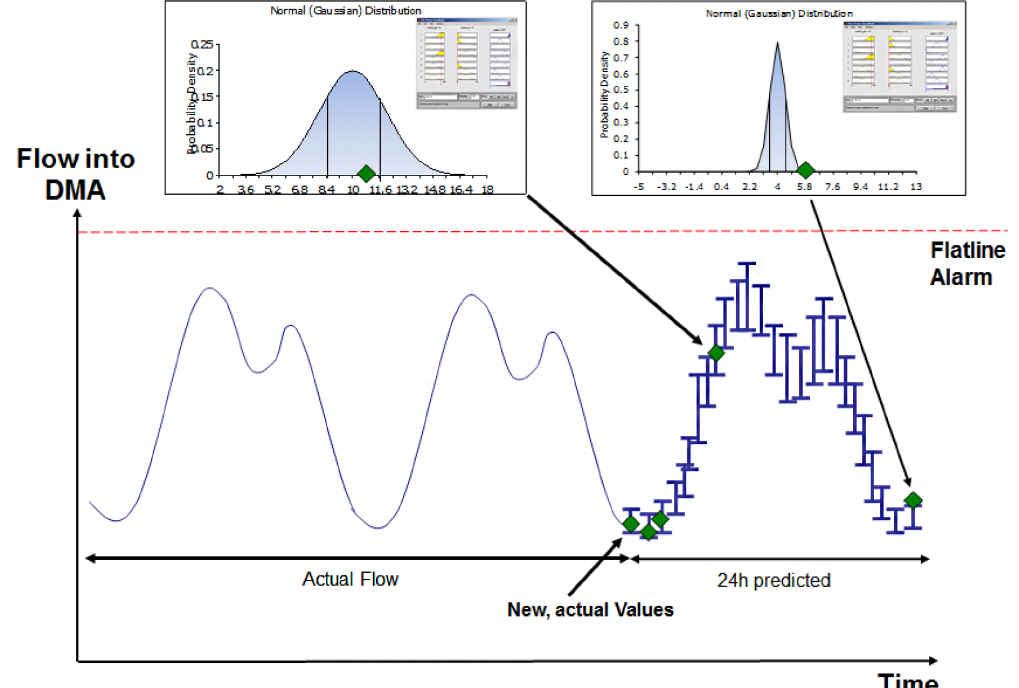
Figure 2. Mixture model for future flow prediction and fuzzy